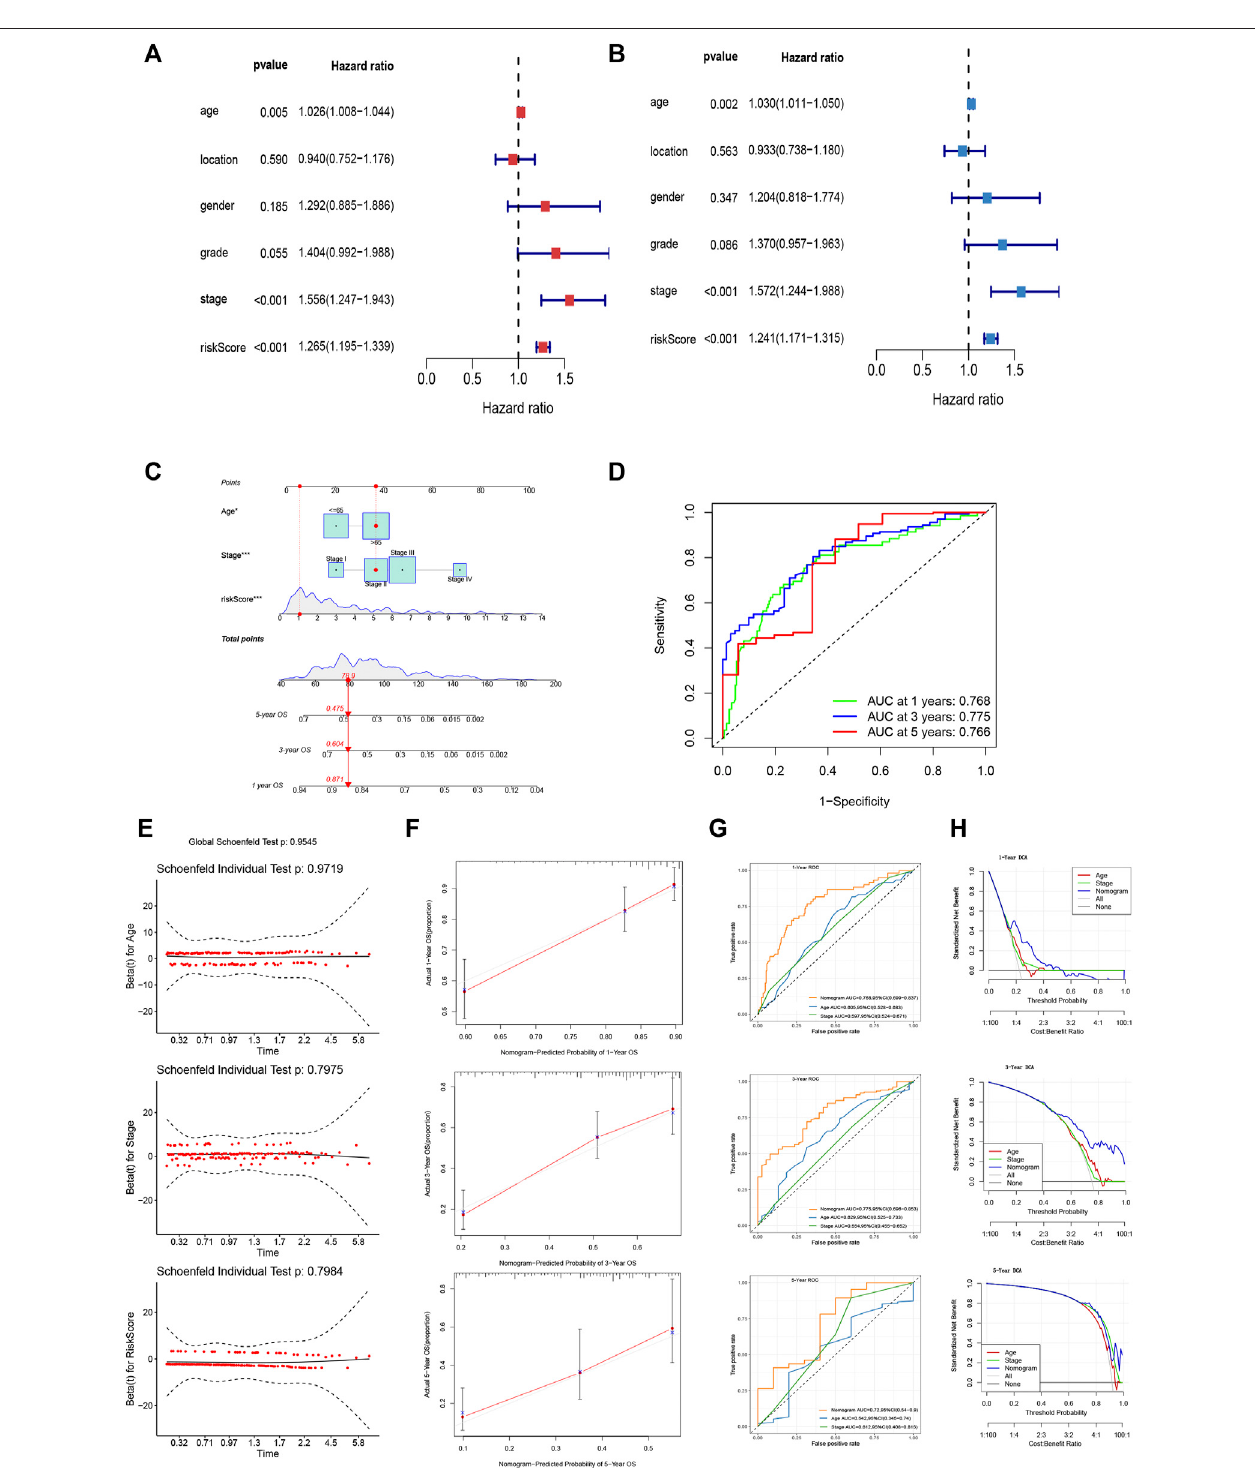
FIGURE3| Evaluation ofFRLP riskscoremodel ’ spredictiveef fi cacy. (A) UnivariateCoxanalysisofriskscoreand otherclinicopathologicalfactors. (B) Multivariate Coxanalysisofriskscoreandotherclinicopathologicalfactors. (C) Nomogramintegratingriskscore,age,andtumorstageforpredicting1-,3-,and5-yearOS. (D) Time- dependent ROC curve of the nomogram for predicting 1-, 3-, and 5-year OS. (E) Schoen fi eld ’ s residual test of age, stage, and risk score. (F) Calibration curves of the nomogram for predicting 1-, 3-, and 5-year OS. The gray lines represent the ideal predictive model, and the red lines represent the observed model. (G) Time- dependent ROC curves evaluating the ef fi cacy of the nomogram to predict 1-, 3-, and 5-year OS. (H) DCA curves estimating the predictive ef fi cacy of the nomogram from the perspective of clinical bene fi t.